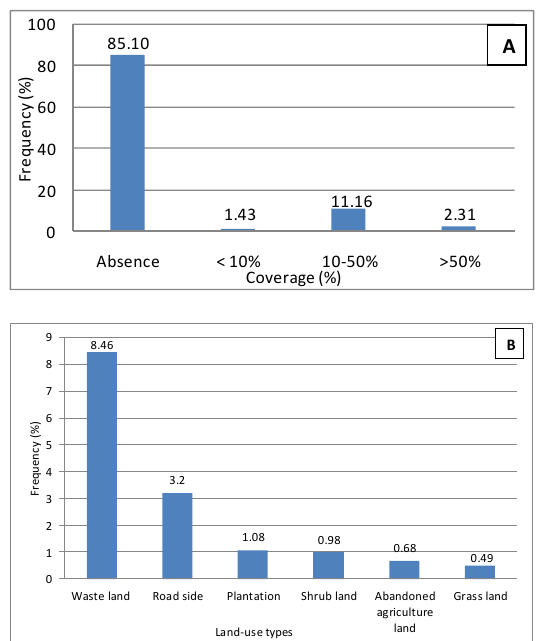
Fig. 2: (A) Occurrence of Parthenium in Kirtipur Municipality; (B) Occurrence of Parthenium across land use types in Kirtipur Municipality